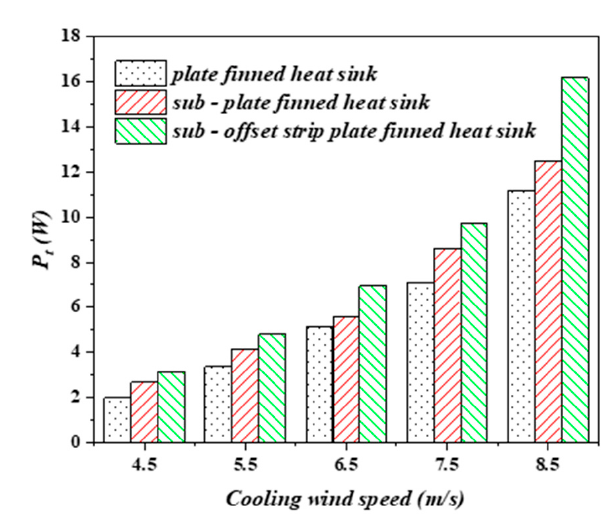
Figure 7. Fan power at different cooling